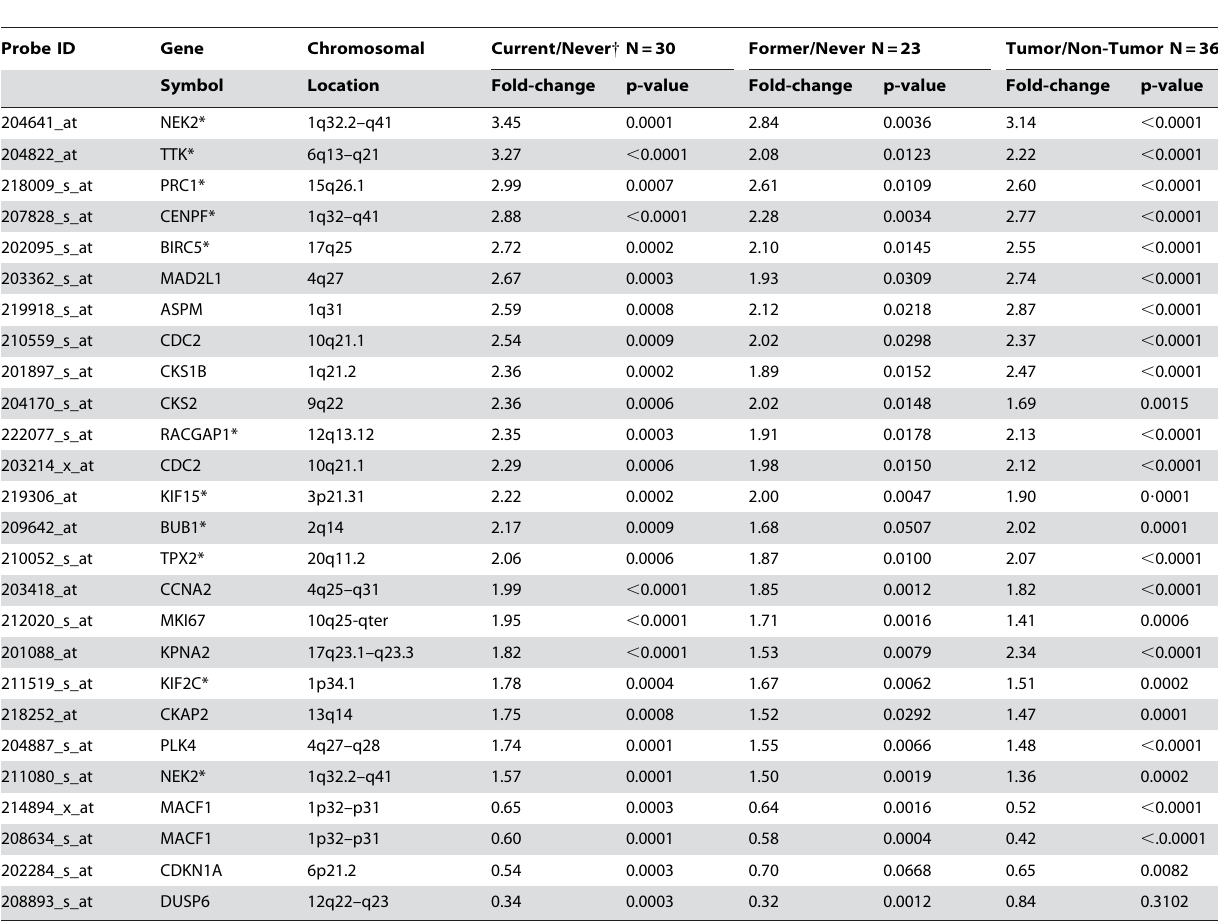
Table 2. Cell cycle genes differentiating current from never smokers (C/N) in the early stage tumor (T) tissue samples, and corresponding values in the former/never smoker (F/N) and in the smokers’ paired tumor/non-tumor tissue (T/NT)